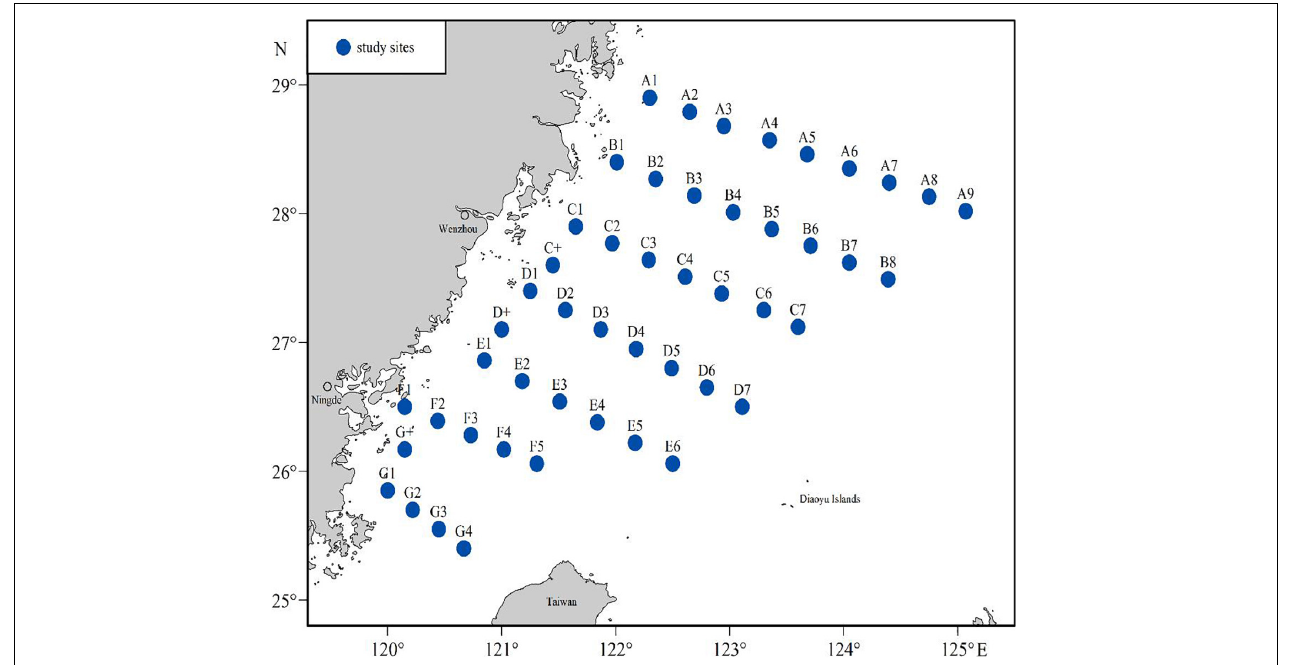
FIGURE 1 | Sites in the south-central East China Sea in November 2018 and April 2019. A total of 49 sites were chosen within 7